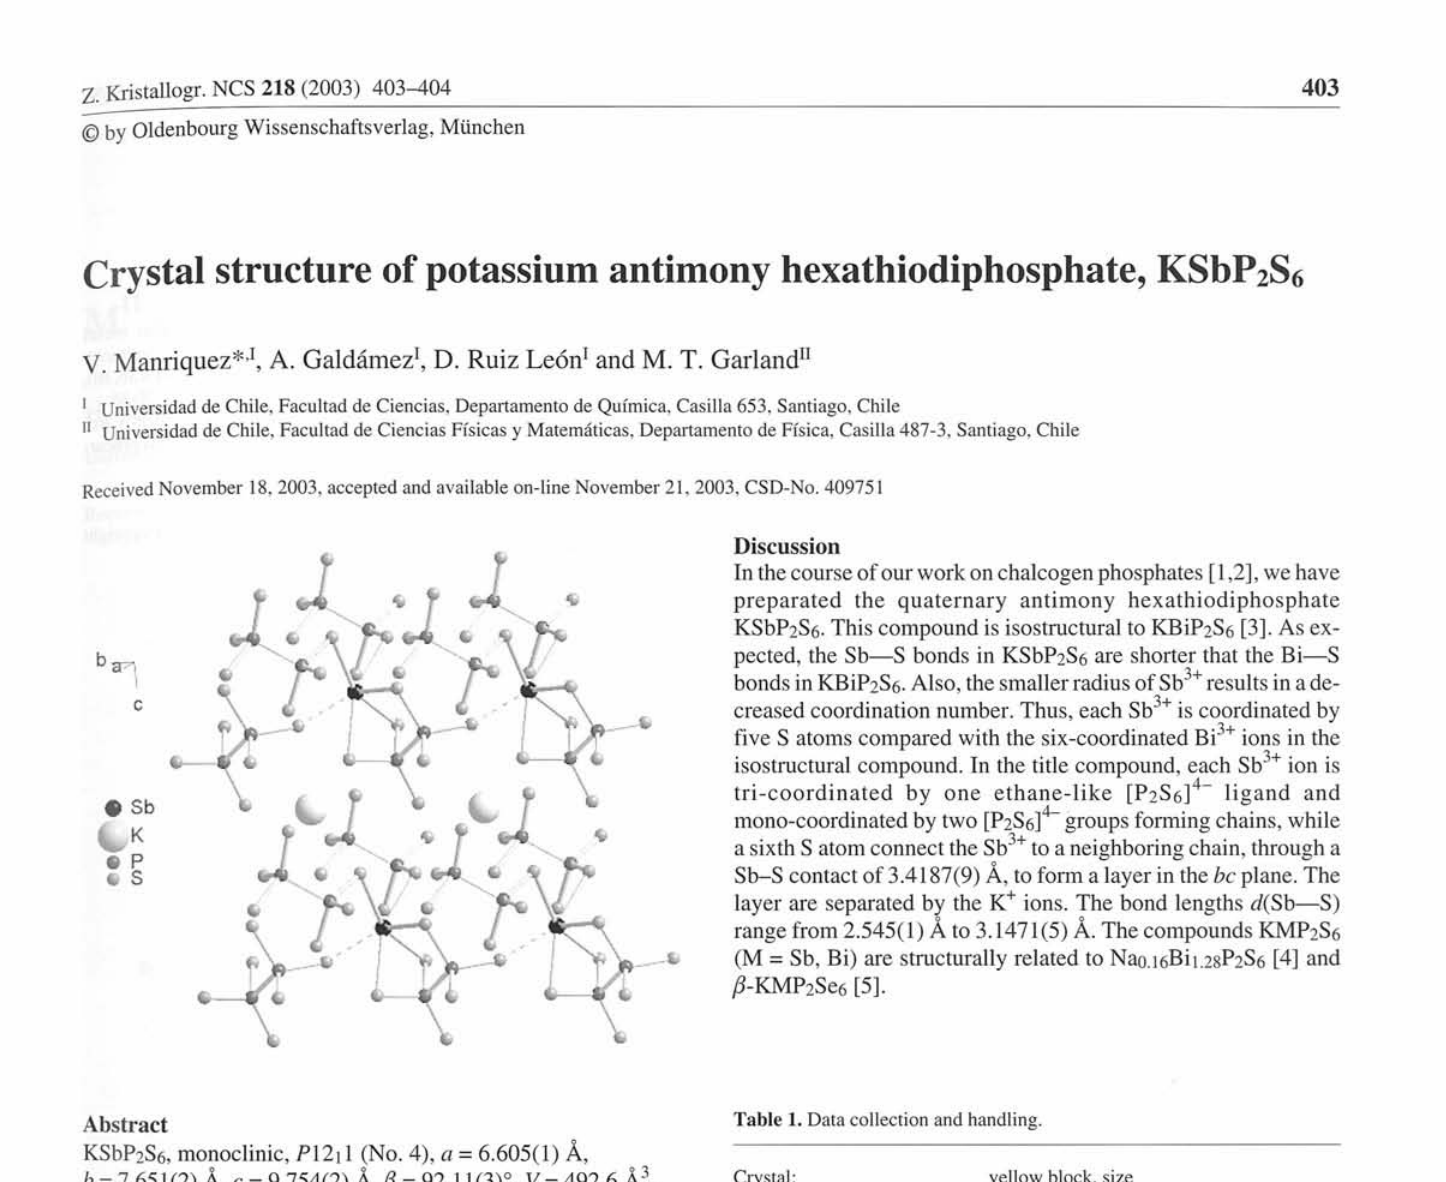
Table 2. Atomic coordinates and displacement parameters (in Â